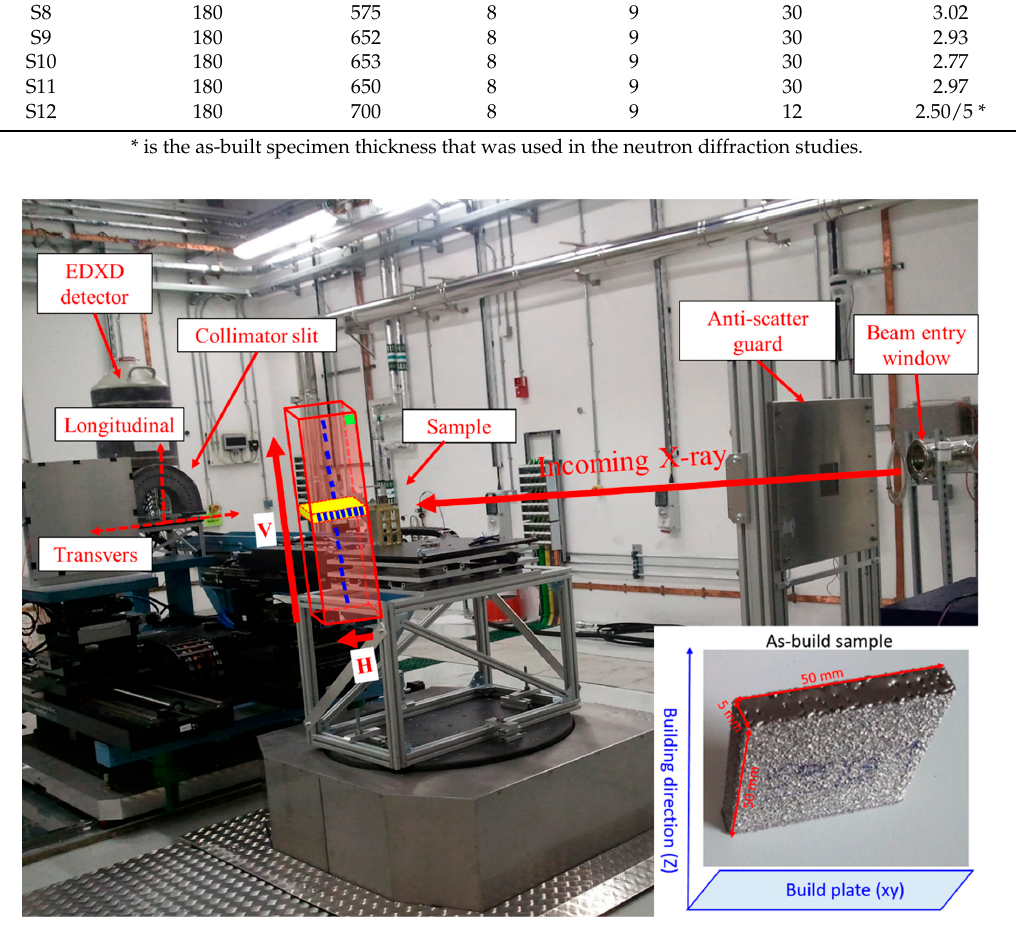
Figure 1. Beam line setup and illustration of measurements. “V” is the vertical direction and “H” is horizontal direction. Each blue and green rectangle represents the measurement locations. Embedded image is a photo of one of the as-built